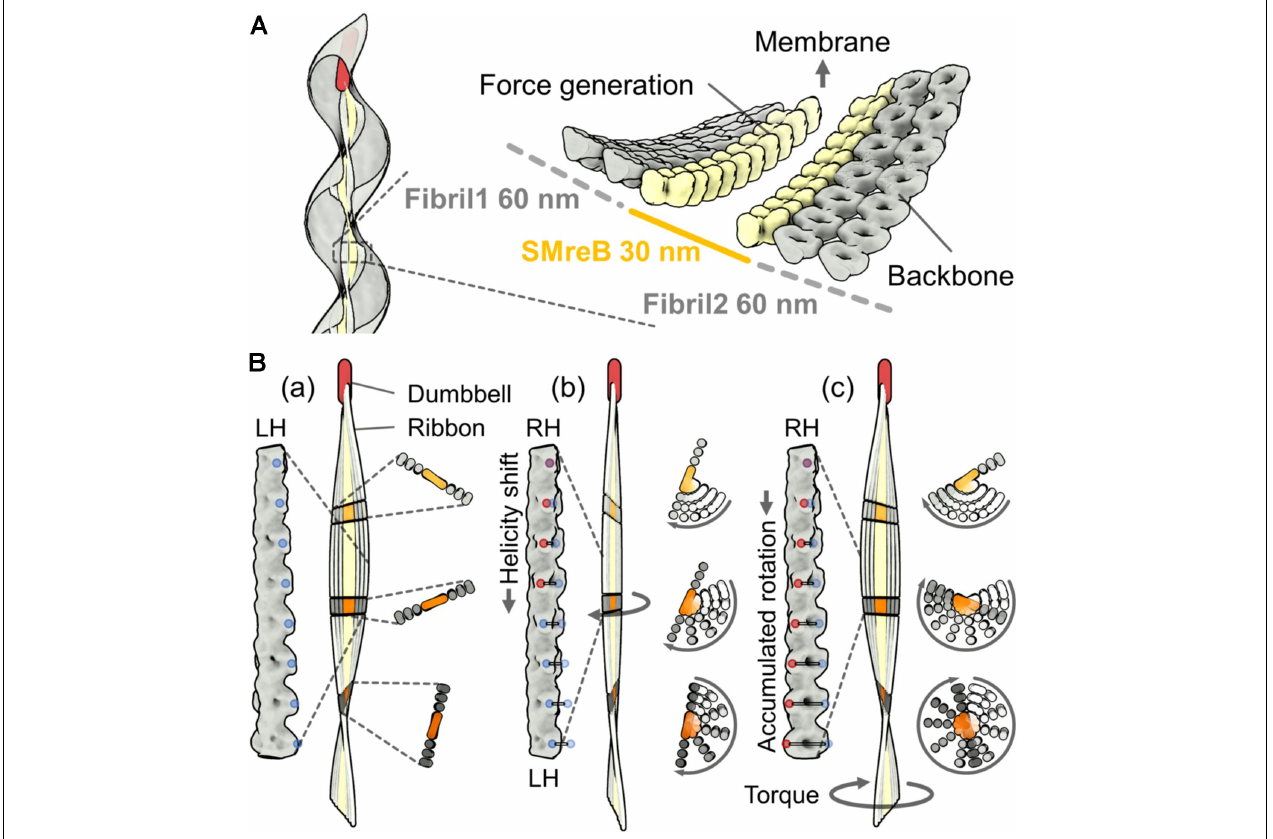
FIGURE 3 | A working model for the helicity shift showing the propulsion of the cell body by pushing the water backward. (A) Left: Ribbon alignment along the innermost line of the helical cell body. Right: A model for ribbon composed of SMreB and fibril filaments, suggested from cryoEM (Kürner et al., 2005). The fibril protein is aligned in the outer zones that are each 60 nm wide. SMreB molecules are aligned in the inner zone that is 30 nm wide. (B) Ribbon rotation caused by accumulated twists. A left-handed ribbon (a), a transition state from left-handedness (LH) to right-handedness (RH) (b), and the resulting right-handed ribbon (c) are presented. The magnified images of the fibril filament in the ribbon, the whole ribbon, and the small stack of the ribbon are shown on the left, center, and right panels, respectively, for the three conformations (a), (b), and (c). The ribbon is fixed at the cell front by a dumbbell structure. The rotation of the small stack from conformation (a) is shown by traces with different transparencies in (b) and (c). The twists of the fibril filaments accumulate with the ribbon rotation. The accumulated twists push the water backward and generate a propulsion force. LH and RH points are marked by blue and red dots, respectively. The traces of the colored dots from the original positions in (a) are shown as horizontal lines in (b) and